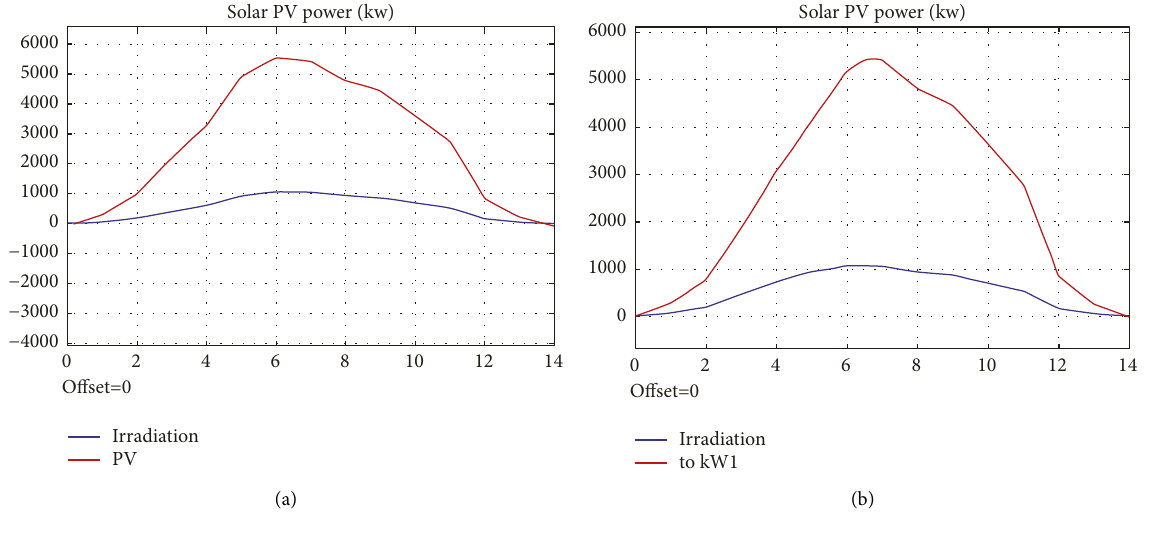
Figure 22: Output power for (a) ANN (b) PO.